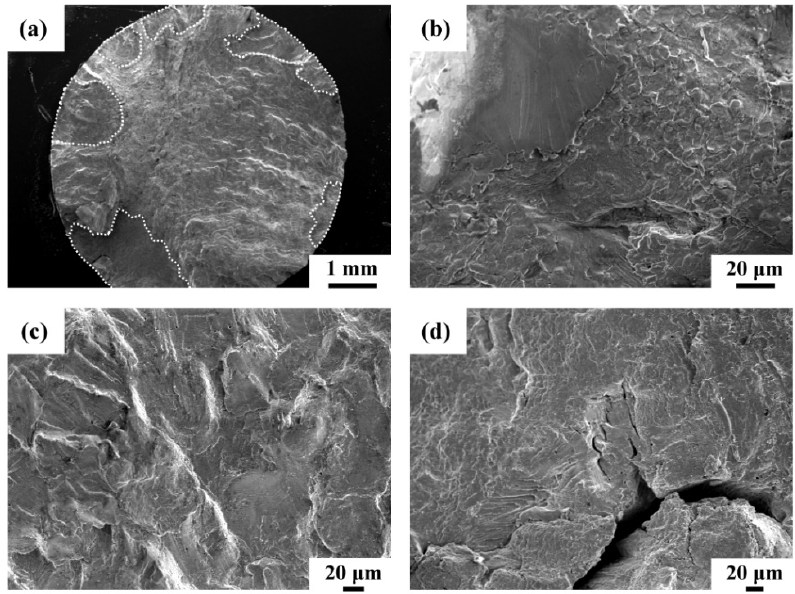
Figure 11. ( a ) Macro-fatigue appearance of the 304 substrate, ( b , c ) fracture features at the crack initiation sites, ( d ) transgranular crack growth with striations.